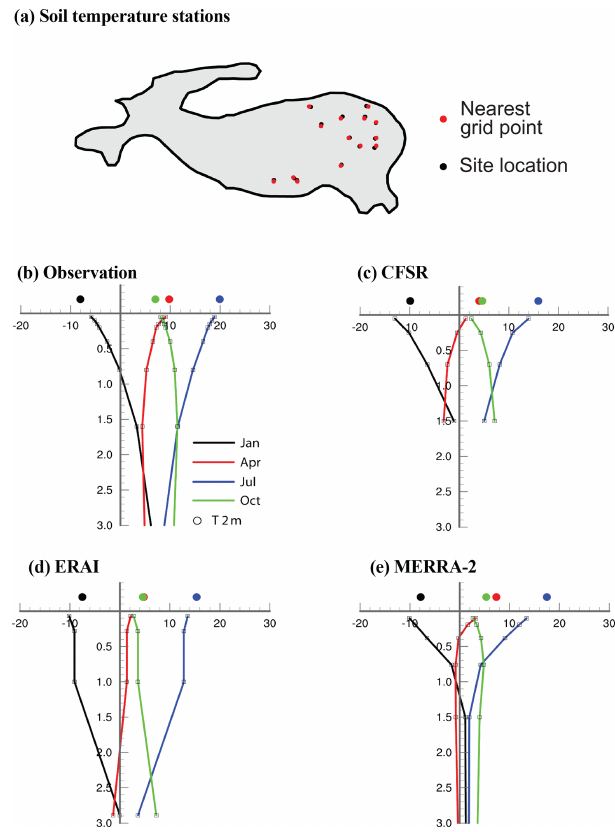
Figure 5. Mean soil temperature profiles in different seasons based on 14 TP stations and compared with different